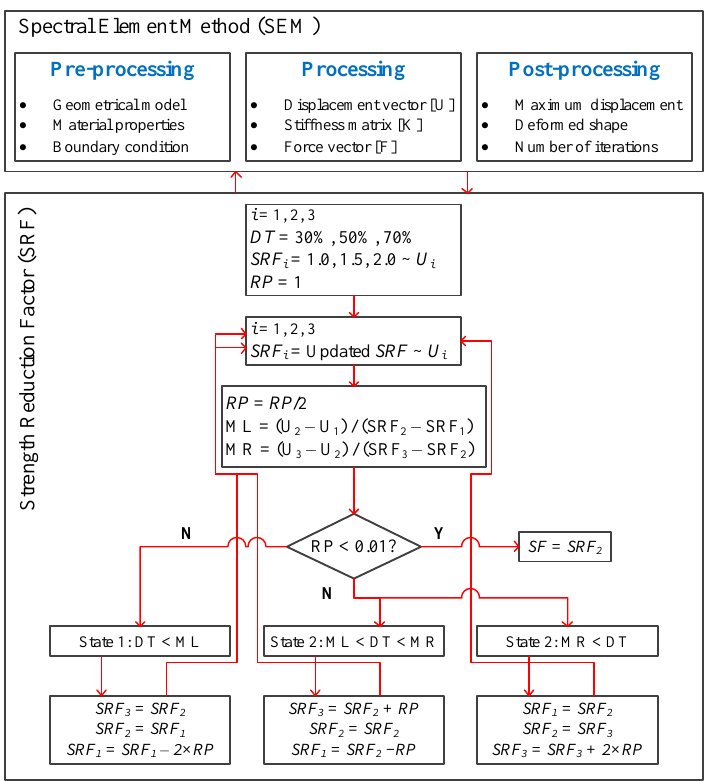
Figure 4. Flowchart of the interaction between SEM and